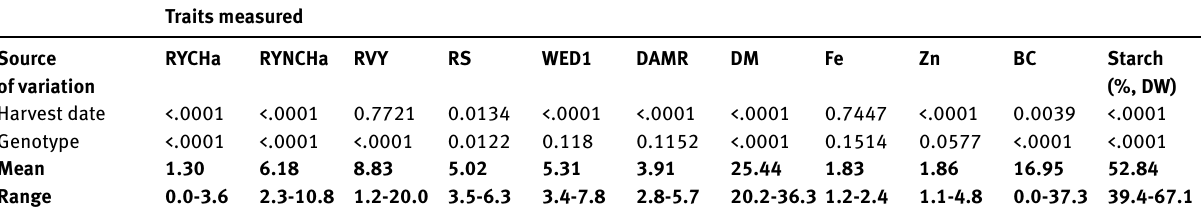
Table 2: P-values of harvesting dates and genotypes on storage root yield, vine yield, root size, weevil damage and nutritional traits ana- lysed across four different harvesting periods at Gurue in 2015 Traits measured